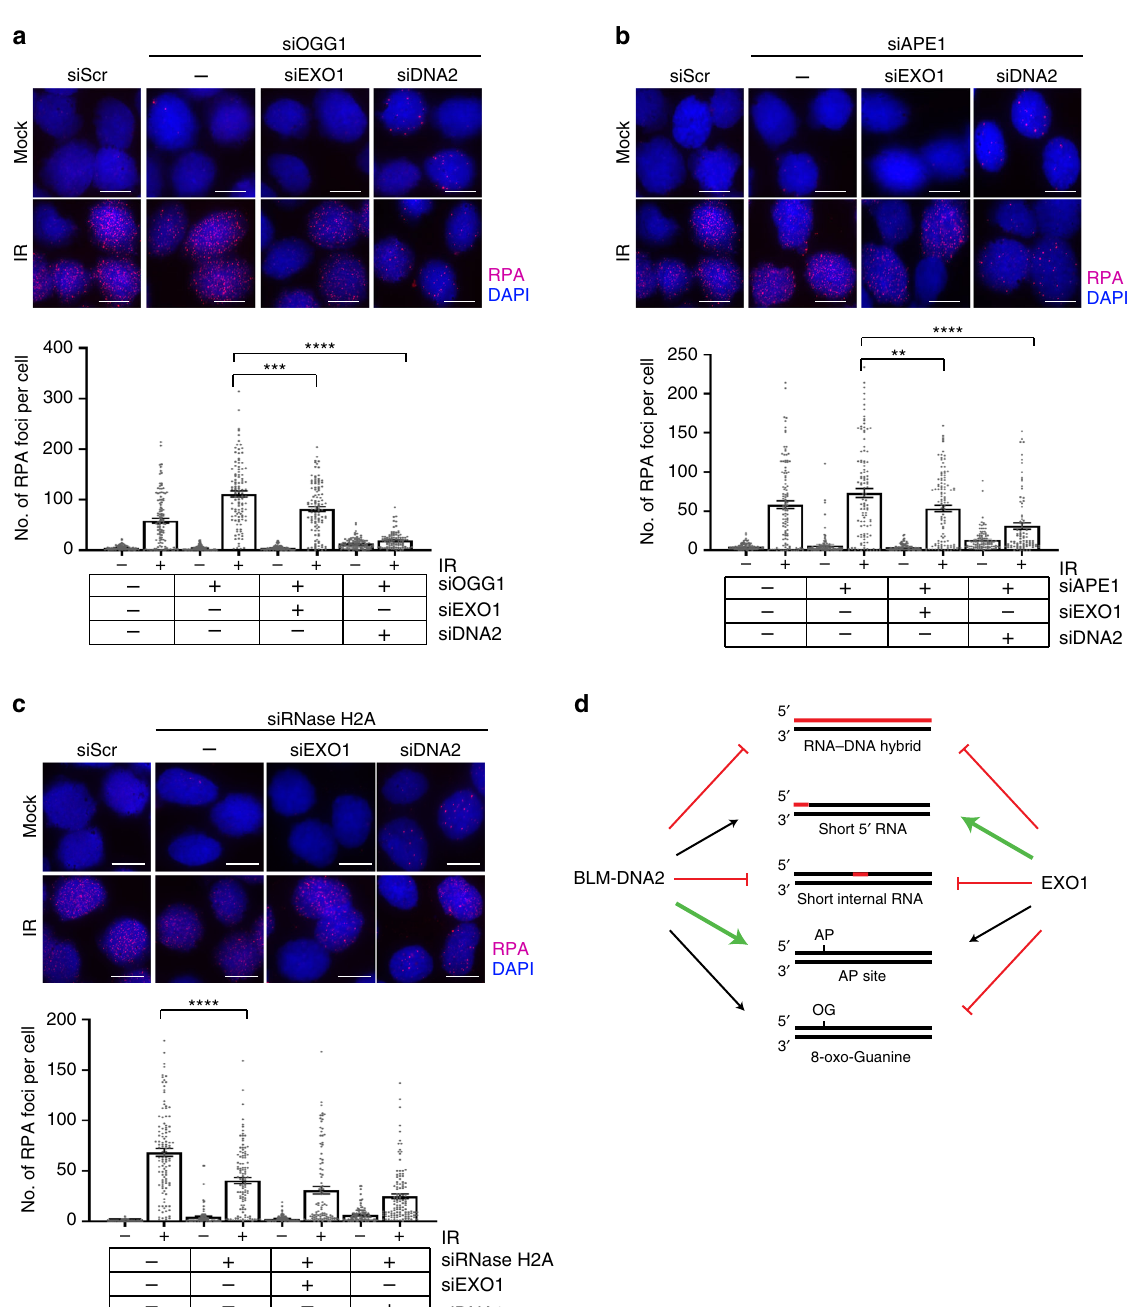
Fig. 6 Biological effects of 8-oxo-G residues, AP sites, and ribonucleotides. a U2OS cells were depleted of OGG1 in combination with EXO1 or DNA2 knockdown using siRNA as indicated. Cells were screened for resection defects by quantifying IR-induced RPA foci 3 h after treatment with 6 Gy IR. Representative images of mock-irradiated or irradiated (IR) cells immunostained with anti-RPA antibody (red) are shown. Nuclei were stained with 4 ′ ,6- diamidino-2-phenylindole (blue). Plot shows average numbers of RPA foci per nucleus. b U2OS cells were depleted of APE1 in combination with EXO1 or DNA2 knockdown using siRNA, and assayed for resection defects as described above. c U2OS cells were depleted of RNase H2A in combination with EXO1 or DNA2 knockdown using siRNA, and assayed for resection defects as described above. All experiments were replicated n = 3 times, and all bars represent the mean. Error bars depict standard error of the mean. ** indicates p = 0.0068; ***, p = 0.0002; ****, p < 0.0001; two-tailed unpaired-t-test. The scale bar represents 10 μ m for all images. d Model summarizing the effect of ribonucleotides, AP sites, and 8-oxo-G residues on resection. Black arrows indicate activity similar to that on control substrates devoid of any lesion, bold green arrows indicate stimulation of resection, and red perpendicular lines indicate attenuation of